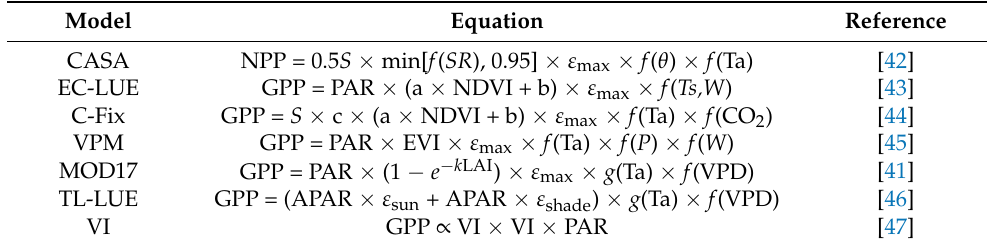
Table 2. Typical LUE models for estimating GPP.